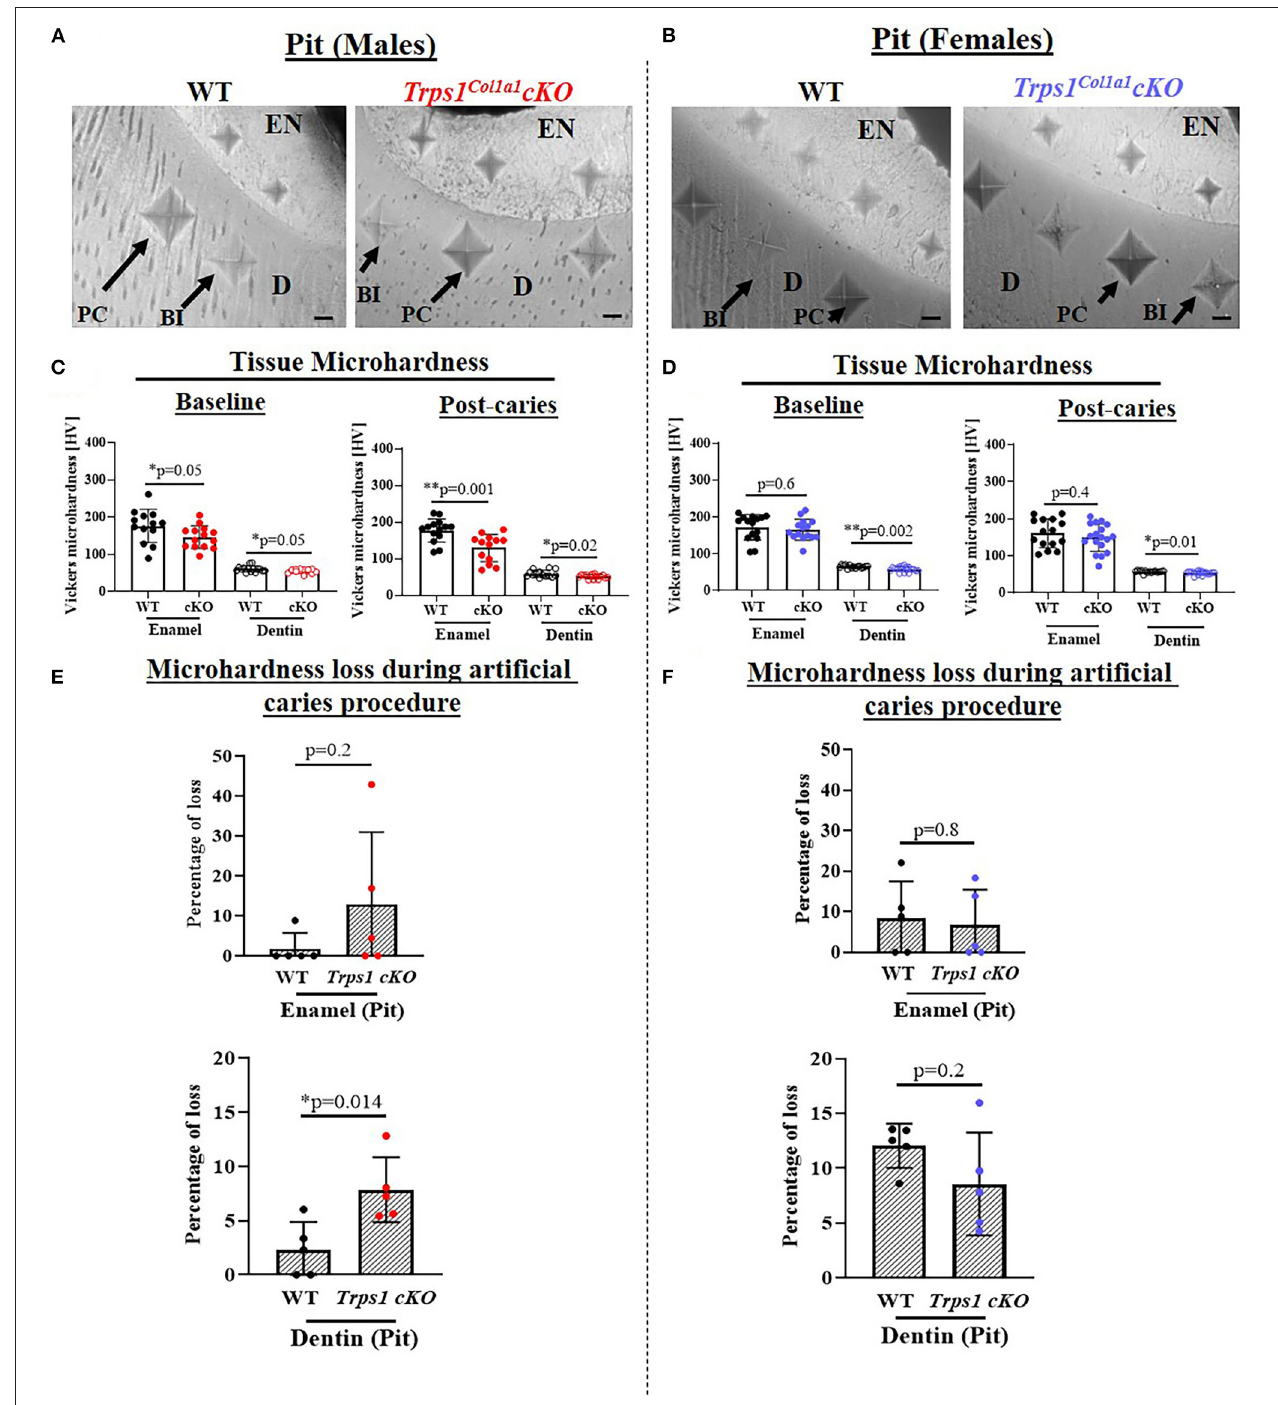
FIGURE 9 | Vickers microhardness analyses of enamel and dentin in the pit of mandibular first molars in 4 wk old WT and Trps1 Col1a1 cKO male and female mice. Three indentations were made per tissue per molar. (A,B) Light microscopy images showing baseline indentations (BI), and indentations made in the enamel (EN) and dentin (D) after the artificial caries procedure (post-caries, PC) in pits; scale bar = 10 µ m. (C,D) Summary of the results of microhardness analyses. Data are shown as values of mechanical hardness (HV) ± SD and individual data points of all indentations performed in each region ( N = 5 molars/genotype/sex, 3 indentations/tissue/molar), * p < 0.05 and ** p < 0.01. (E,F) Graphs illustrating the percentage of microhardness loss during the artificial caries procedure. Data are shown as mean values of the % of microhardness loss ± SD and individual data points per mouse molar.